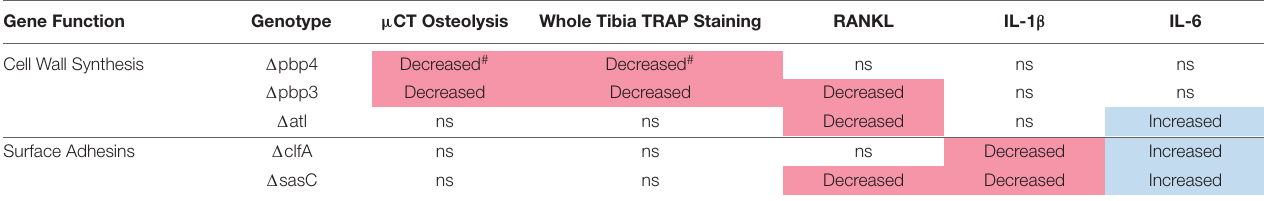
FIGURE 8 | Staphylococcus aureus cell wall synthesis and surface adhesin mutants show significant changes in host proinflammatory cytokine production at the infection site. Local concentrations of IL-1 β (A,B) and IL-6 (C,D) were quantified for each infection genotype as well as within contralateral limbs by measuring via ELISA of bone tissue homogenate. Significance was evaluated by one-way ANOVA with Dunnett’s post-hoc for multiple comparisons vs. WT, ∗ p < 0.05, ∗∗ p < 0.01, ∗∗∗ p < 0.001, n = 4–6. TABLE 3 | Host response to infection by S. aureus deletion